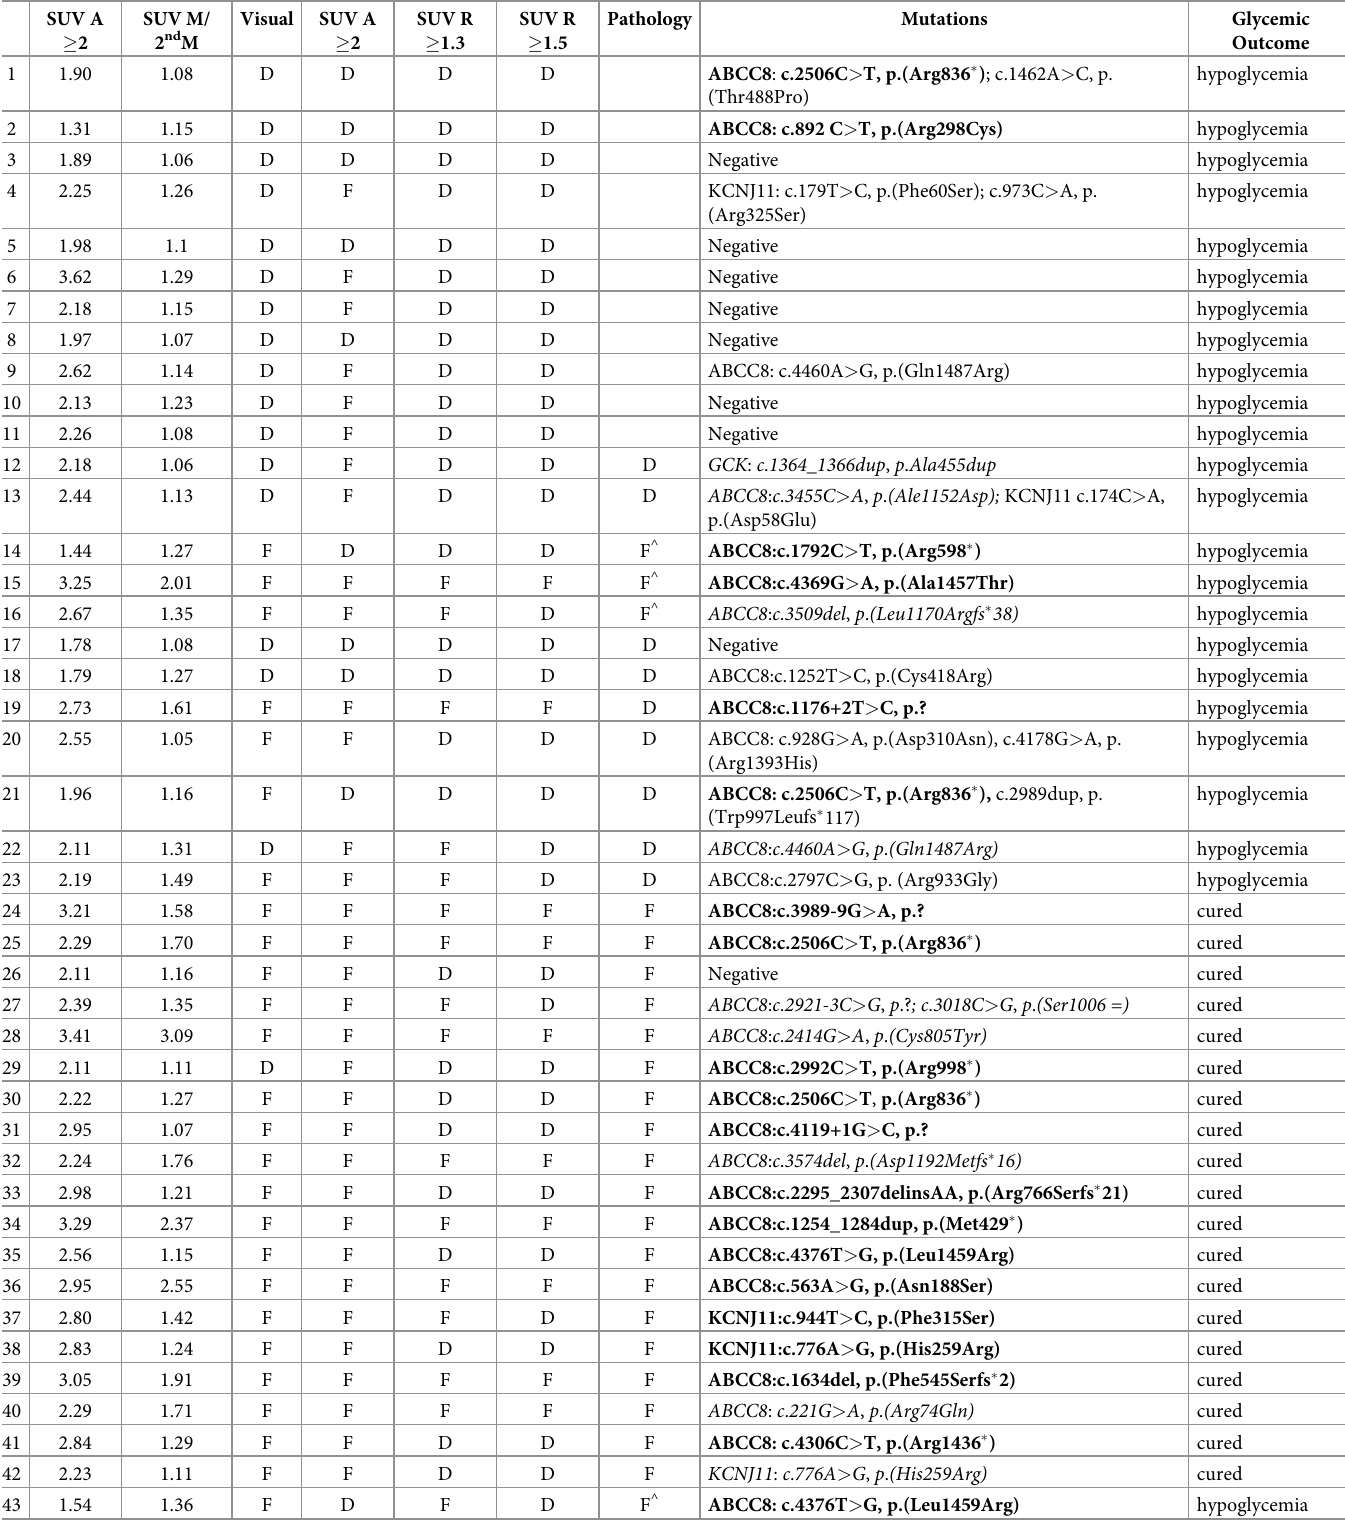
Table 2. Individual subject